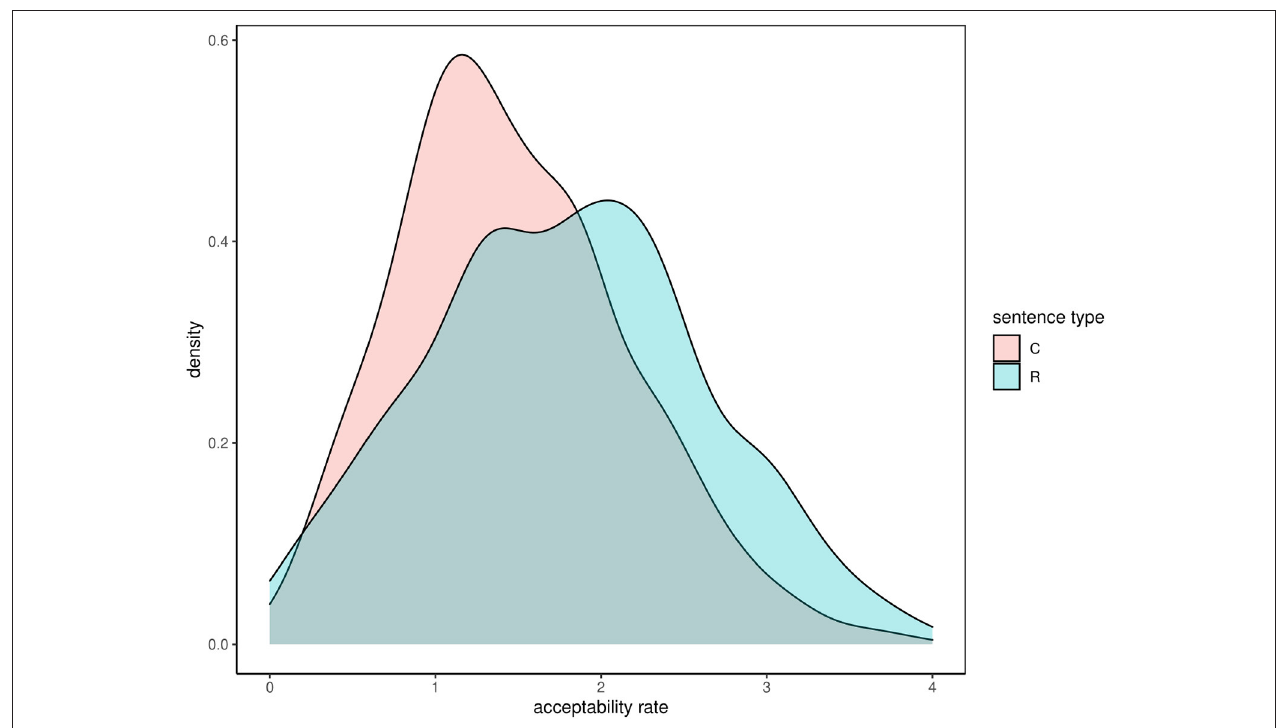
FIGURE 1 | Difference between acceptability rates for real (R) and constructed (C) sentences.